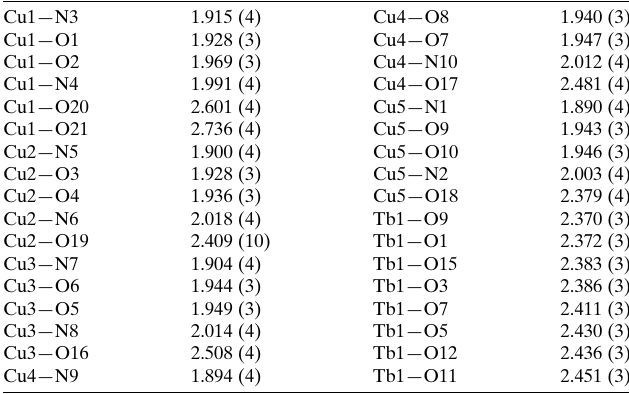
Table 1 Selected bond lengths (A˚ ).